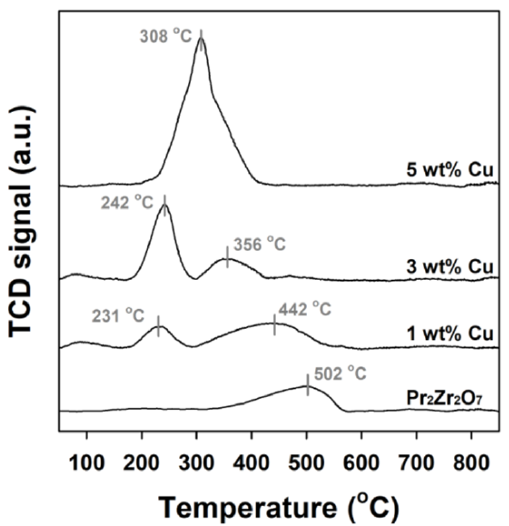
Figure 6. Catalytic performance of Cu/Pr 2 Zr 2 O 7 (1, 3, and 5 wt % Cu) in the cross-coupling of acetone with butanol. Reaction conditions: 20 g reactant with the butanol/acetone mole ratio of 2, catalyst 1 g, 240 °C, and 20 h.